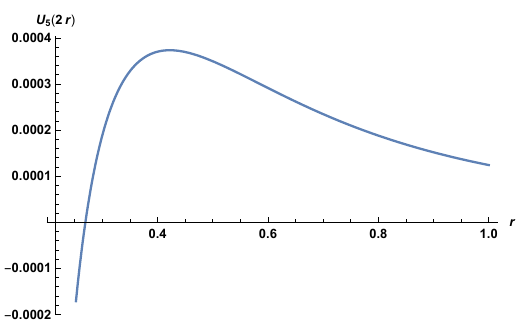
Figure 4 . The shape of the potential U N (2 r ) with T 3 = 1, L = 0 : 01 and (cid:3) = 1 ; N =